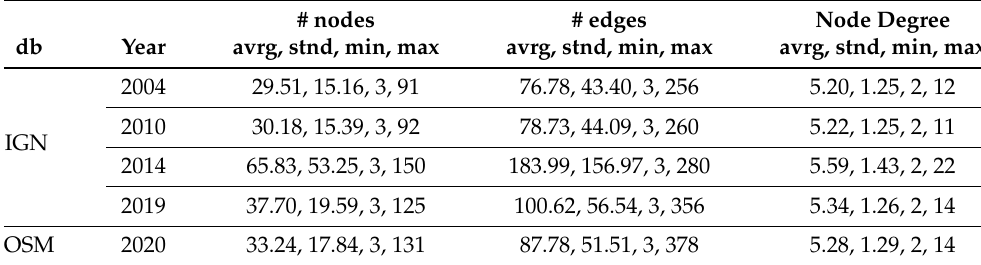
Table 2. Single department statistics example. # nodes #